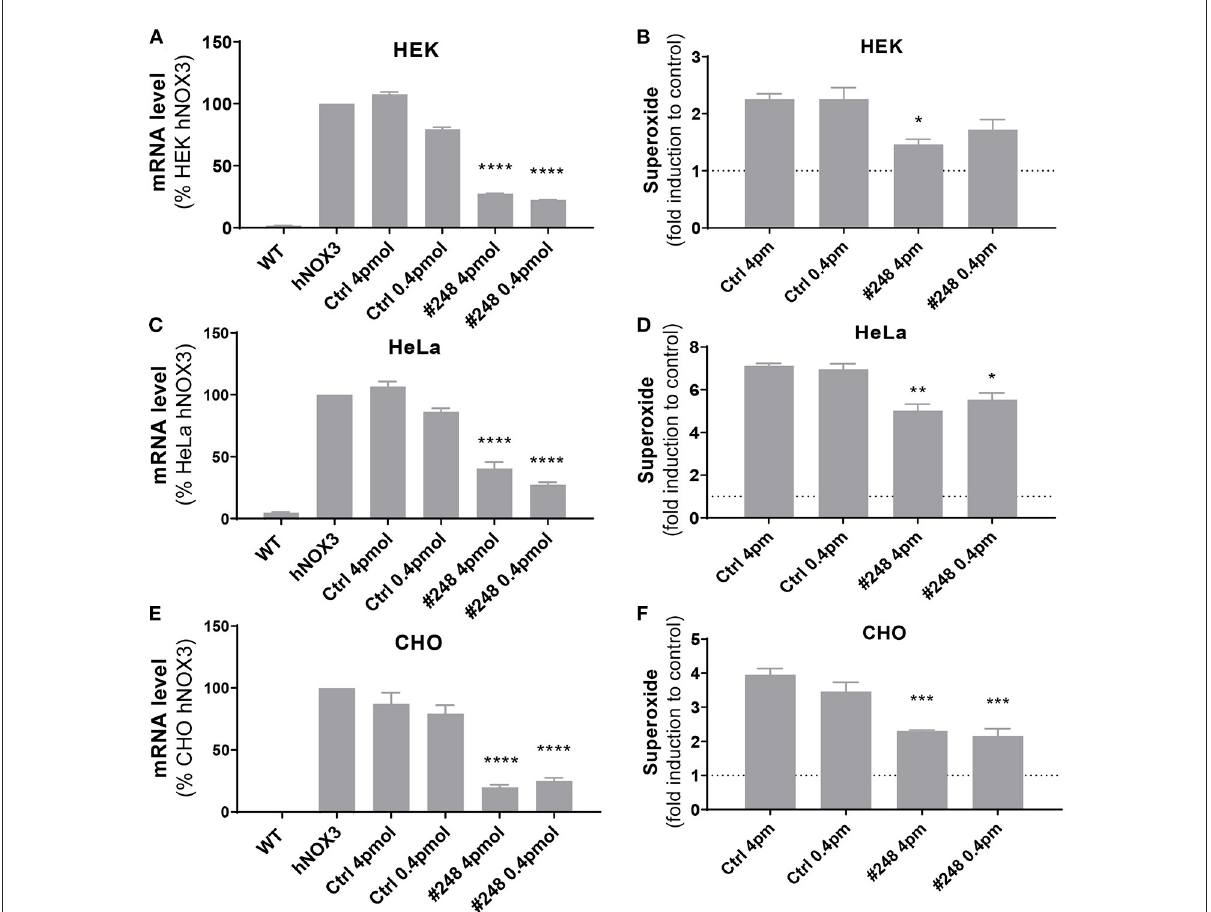
FIGURE5 Validation of the efficiency of siRNA #248 on the human NOX3 complex. (A,B) HEK, (C,D) HeLa and (E,F) CHO cell lines expressing the human NOX3 complex (NOX3, CYBA, NOXO1 and NOXA1) were transfected with siRNA #248 or control siRNA (Ctrl) at two concentrations (4 and 0.4 pmol). (A,C,E) 48h later, NOX3 mRNA was measured by qPCR in the three cell lines and (B,D,F) NADPH oxidase of NOX3 assessed using WST-1 assay. NOX3 mRNA expression was normalized to non-transfected hNOX3 expressing cells (100%). NOX3 activity was normalized to WT cells (1). Data represent the average of three independent experiments + -